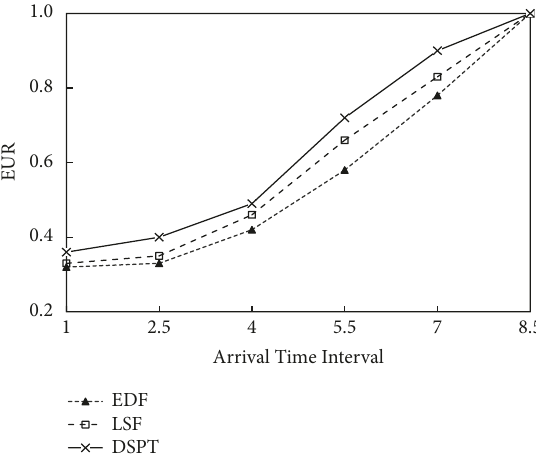
Figure 4: EUR results.